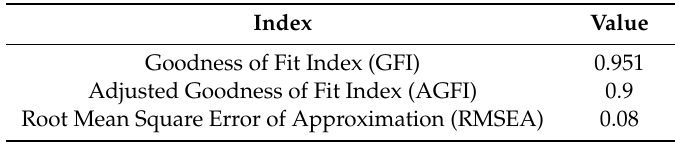
Table 2. Reliability indexes’ values for the model